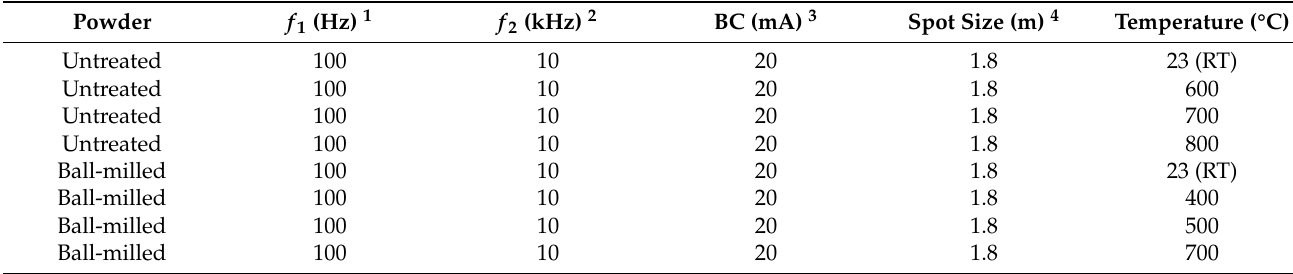
Table 2. Summary of smoke tests.